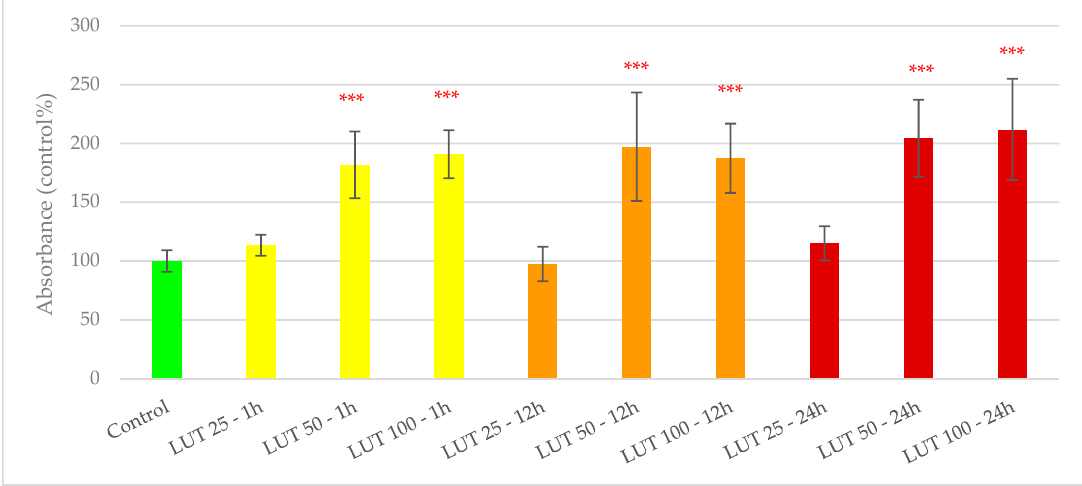
Figure 1. Viability of IPEC-J2 cells after treatment with purified grape seed oligomeric proanthocyanidins (GSOPs). Control—plain cell culture medium treatment for 1 h; GSOP 50—1 h: 50 μ g/mL GSOP treatment for 1 h; GSOP 100—1 h: 100 μ g/mL GSOP treatment for 1 h; GSOP 200—1 h: 200 μ g/mL GSOP treatment for 1 h; GSOP 50—12 h: 50 μ g/mL GSOP treatment for 12 h; GSOP 100— 12 h: 100 μ g/mL GSOP treatment for 12 h; GSOP 200—12 h: 200 μ g/mL GSOP treatment for 12 h; GSOP 50—24 h: 50 μ g/mL GSOP treatment for 24 h; GSOP 100—24 h: 100 μ g/mL GSOP treatment for 24 h; GSOP 200—24 h: 200 μ g/mL GSOP treatment for 24 h. Data are shown as means with standard deviations, n = 6/group. Significant difference compared to the untreated control: ** p < 0.01, *** p < 0.001; in red: higher values than control.